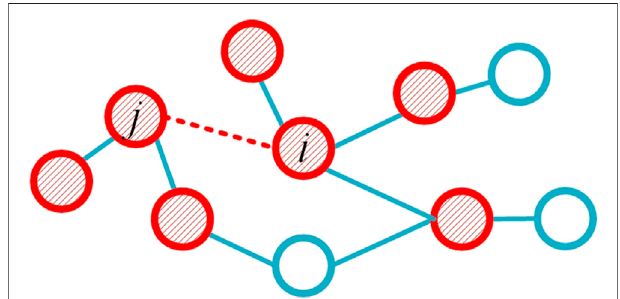
FIGURE 2 | Local communication